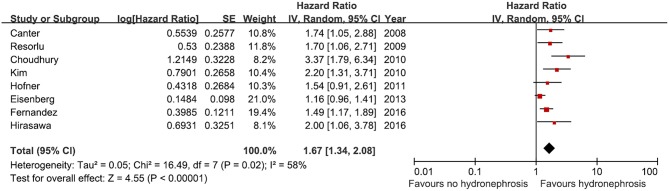
Forest plot and meta-analysis of cancer specific survival after radical cystectomy according to preoperative hydronephrosis. SE, standard error; IV, inverse variance; CI, confidence interval; df, degrees of freedom.